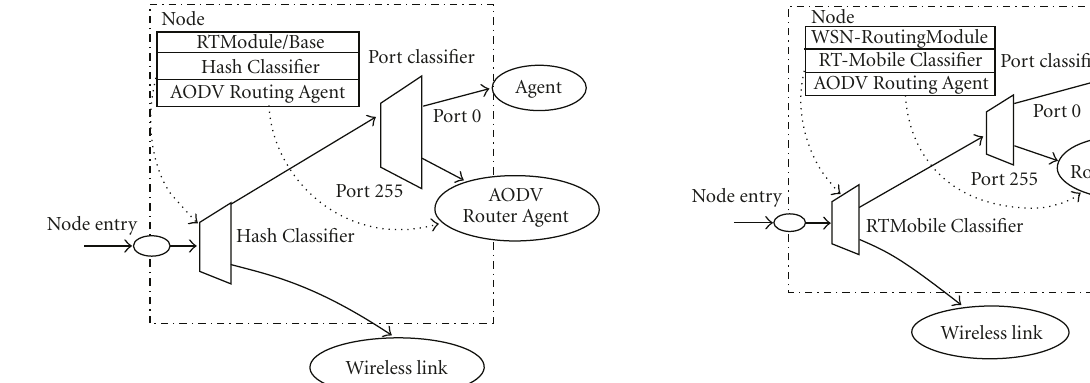
Figure 9: Modified architecture of Wireless Node in